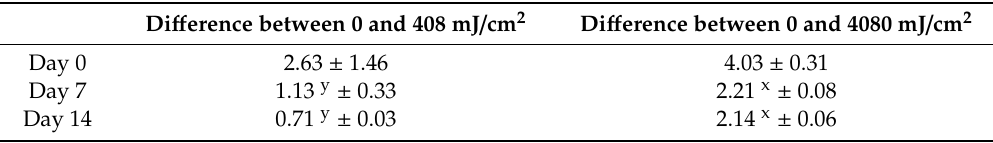
Table 6. Mean and standard error values for the color di ff erences ( ∆ E) between the untreated and UV-C irradiated samples ( n = 3).